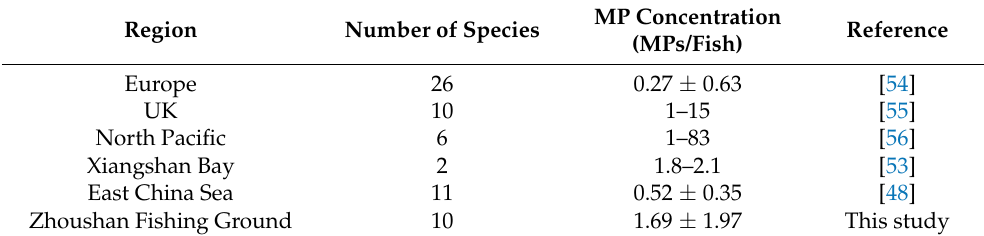
MP Concentration (MPs/Fish)